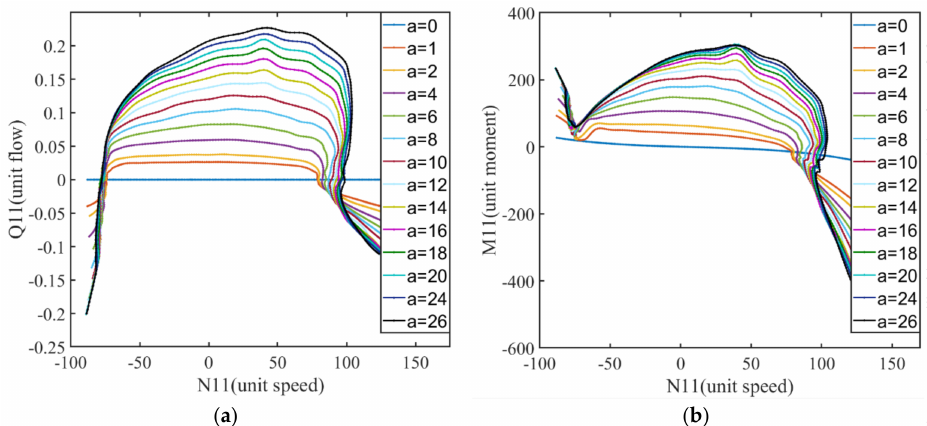
Figure 3. The characteristic curves of a pump turbine: ( a ) flow characteristic curve; and ( b ) moment characteristic curve.